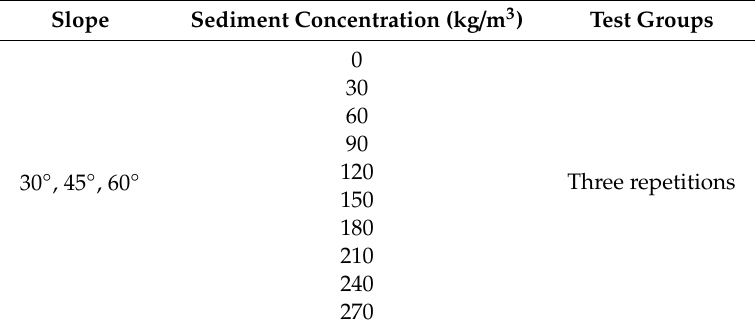
Table 2. Test group